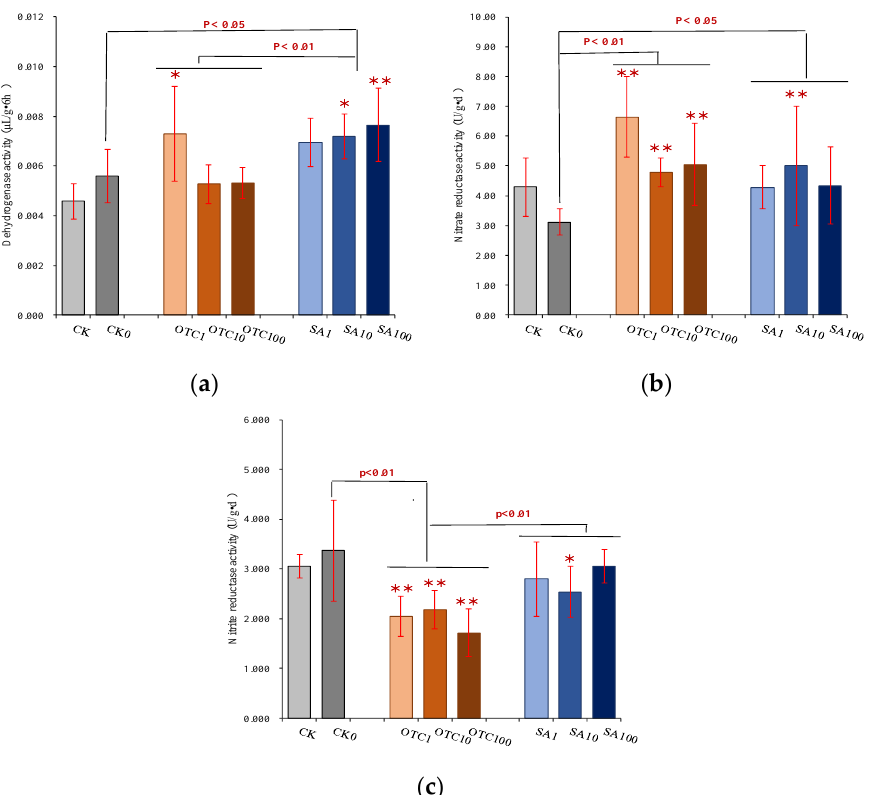
Figure 2. Changes of soil enzyme activities of rhizosphere soil with different treatments. ( a ) Soil dehydrogenase activity; ( b ) Soil nitrate reductase activity; ( c ) Soil nitrite reductase activity. CK is the soil without manure-based fertilizer; CK0 shows the soil with manure-based fertilizer at 0 mg/kg antibiotic concentration; OTC1 is the soil with manure-based fertilizer at 1 mg/kg OTC concentration; OTC10 is the soil with manure-based fertilizer at 10 mg/kg OTC concentration; OTC100 indicates the soil with manure-based fertilizer at 100 mg/kg OTC concentration; SA1 is the soil with manure-based fertilizer at 1 mg/kg SA concentration; SA10 is the soil with manure-based fertilizer at 10 mg/kg SA concentration; SA100 presents the soil with manure-based fertilizer at 100 mg/kg SA concentration. * or ** represents significant differences ( p < 0.05 or p < 0.01) between each antibiotic treatment (e.g., OTC1, OTC10) and CK0; and p < 0.05 or p < 0.01 on the line represents significant differences between treatment groups such as control, OTC, and SA treatments.